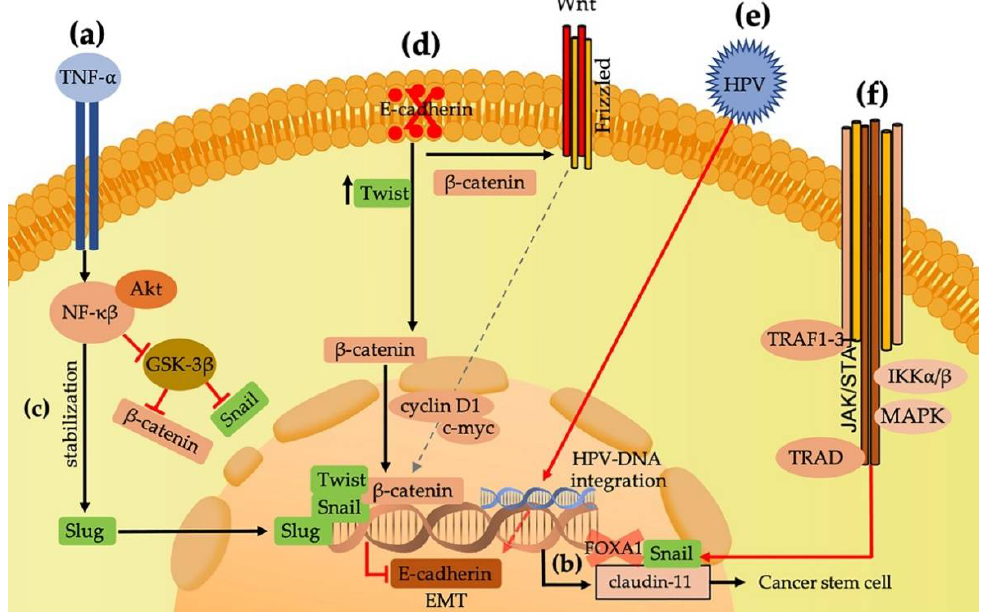
Figure 1. ( a ) TNF- α increases the expression of Snail and Slug, regulates the expression of Twist, and inhibits GSK-3 β through the phosphorylation of NF- κβ and Akt signaling pathways that induce the stabilization of Slug and β -catenin, promoting the induction of epithelial–mesenchymal transition (EMT). ( b ) The overregulation of Snail in conjunction with claudin-11 is related to the promotion of cancer stem cells (CSC) and circulating tumor cells (CTC). ( c ) The stabilization and overregulation of Slug are related to the inhibition of E-cadherin. ( d ) The low expression of E-cadherin induces the cytoplasmic overexpression of Twist and release of β -catenin to the cytoplasm, WNT canonic pathway activation, nuclear translocation of β -catenin and c-myc, and cyclin D1 amplification; the nuclear expression of Twist induces the loss of E-cadherin. ( e ) Viral HPV particles promote EMT by inducing the overexpression of Snail, Slug, and Twist and promoting the low expression of E-cadherin. ( f ) Latent membrane protein 1 (LMP1) is related to several signaling pathways that promote EMT via the induction of Snail and inhibition of E-cadherin, which is also related to the overexpression of Twist and inhibition of FOXA1-associated promotion of EMT.